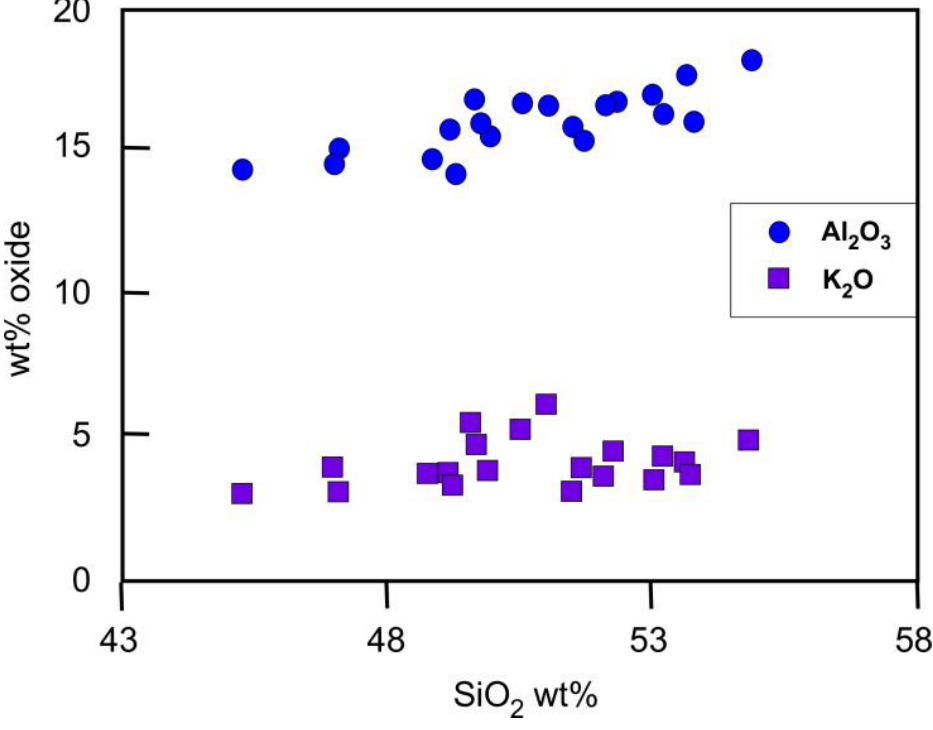
Figure 5. Melt compositions in the melt traps from Experiment G128 (2 GPa, 1125 °C). SiO 2 , Al 2 O 3 and K 2 O contents show variation, probably due to different path lengths through the peridotite. In most experiments the melts in the extraction traps have a significantly higher Mg# than the residual lamproite melt (averages 74.6 vs. 66.4), lower K 2 O/Na 2 O (averages 2.7 vs. 6.3) and also lower BaO, K 2 O/Na 2 O and K/Al ratios (averages 0.50 vs. 0.80). This reflects the uptake of K 2 O and Ba in phlogopites that grew in the peridotite and the buffering of the Mg# by the peridotite minerals because the volume of the peridotite greatly exceeds that of the reacting melt. The compositions of melts in the residue of the lamproite section are much less variable than melts in the carbon traps, particularly in terms of Mg# (Figure 6b). Examples of compositional parameters are shown in Figure